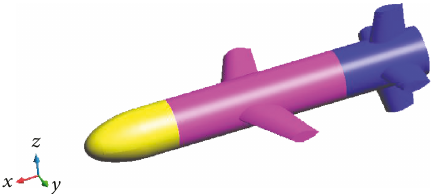
Figure 8: Model of the missile divided into three parts.